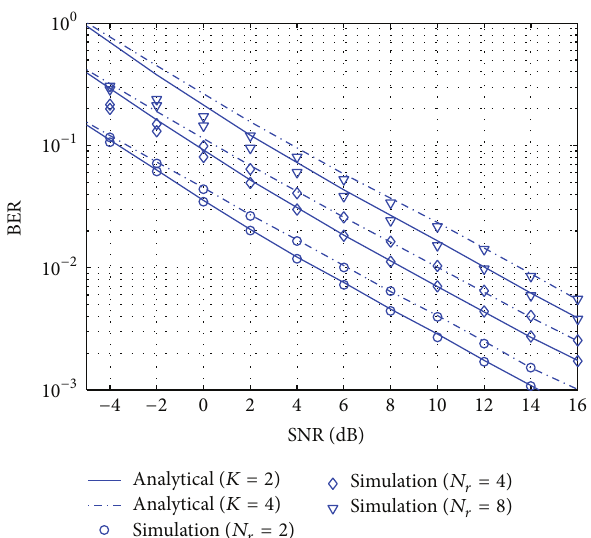
Figure 5: BER of subchannel selection method and zero-padding method with 𝐾 = 2 and 𝐾 = 4 and 𝑁 𝑡 = 16 for QPSK modulation.